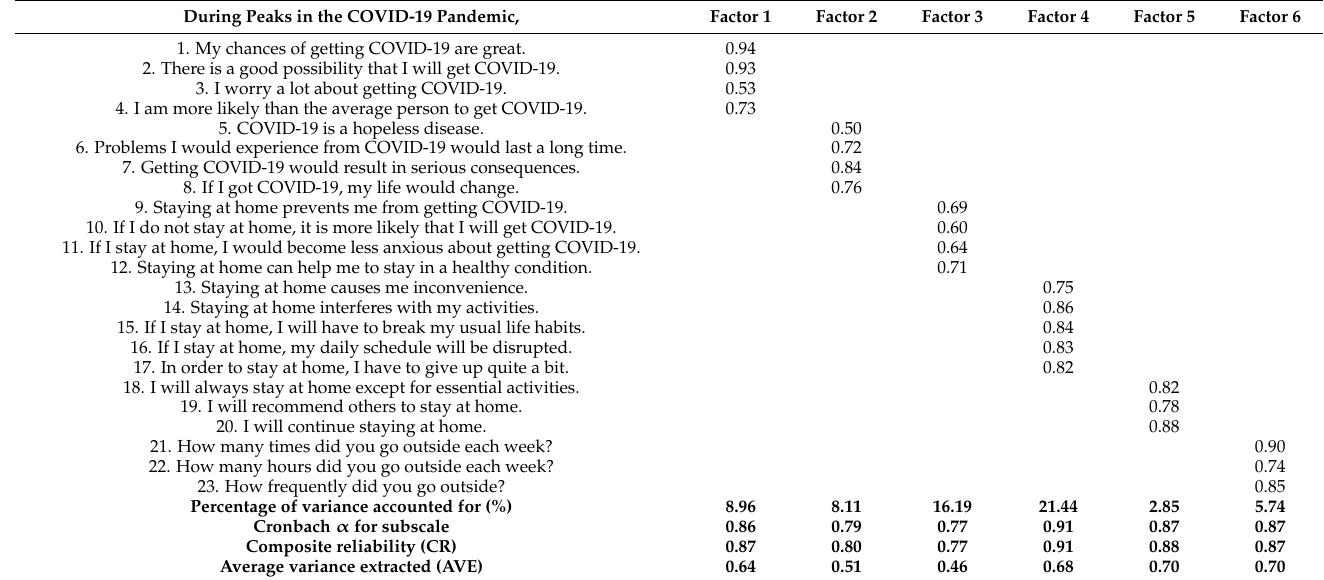
Table 1. The exploratory factor analysis results of the measures. During Peaks in the COVID-19